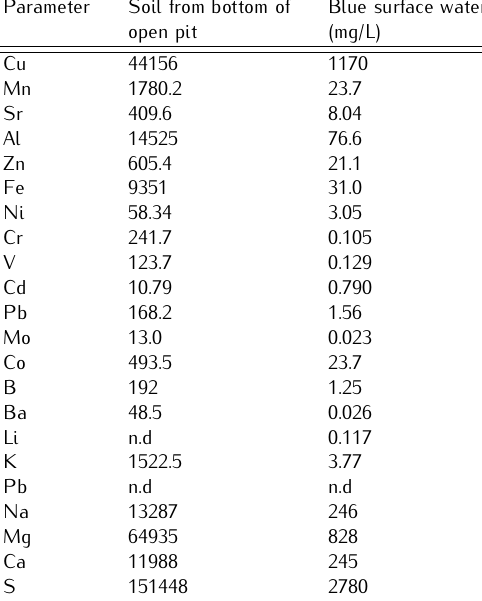
Table 3. Concentrations of heavy metals in the soil and water in the open pit. Parameter Soil from bottom of